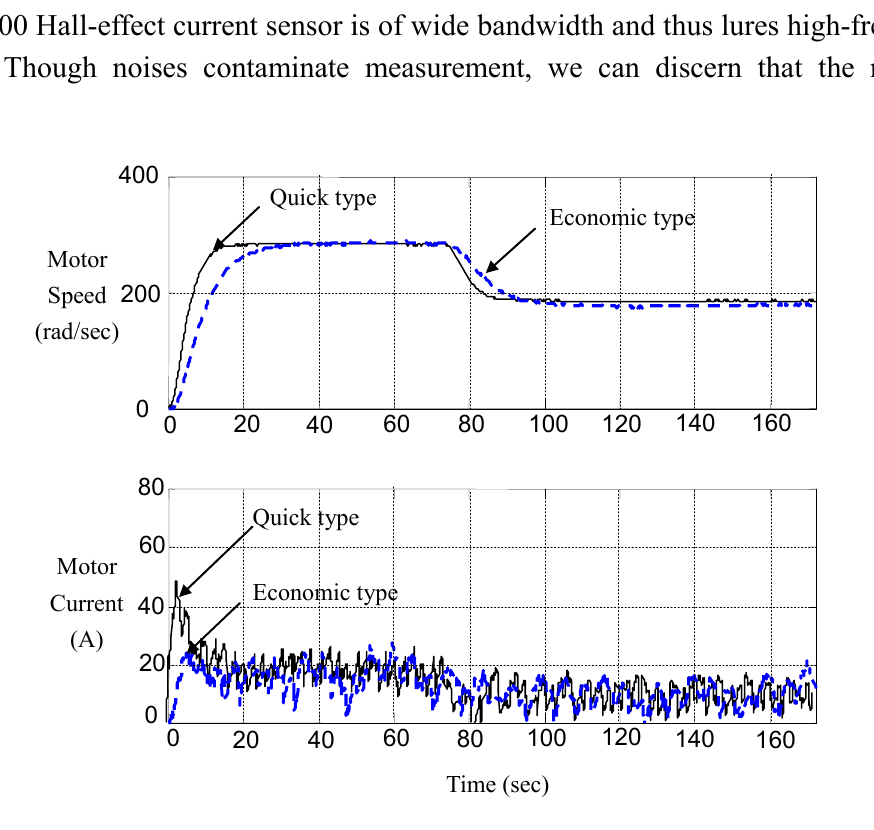
Figure 11. Measured responses of economic type and quick